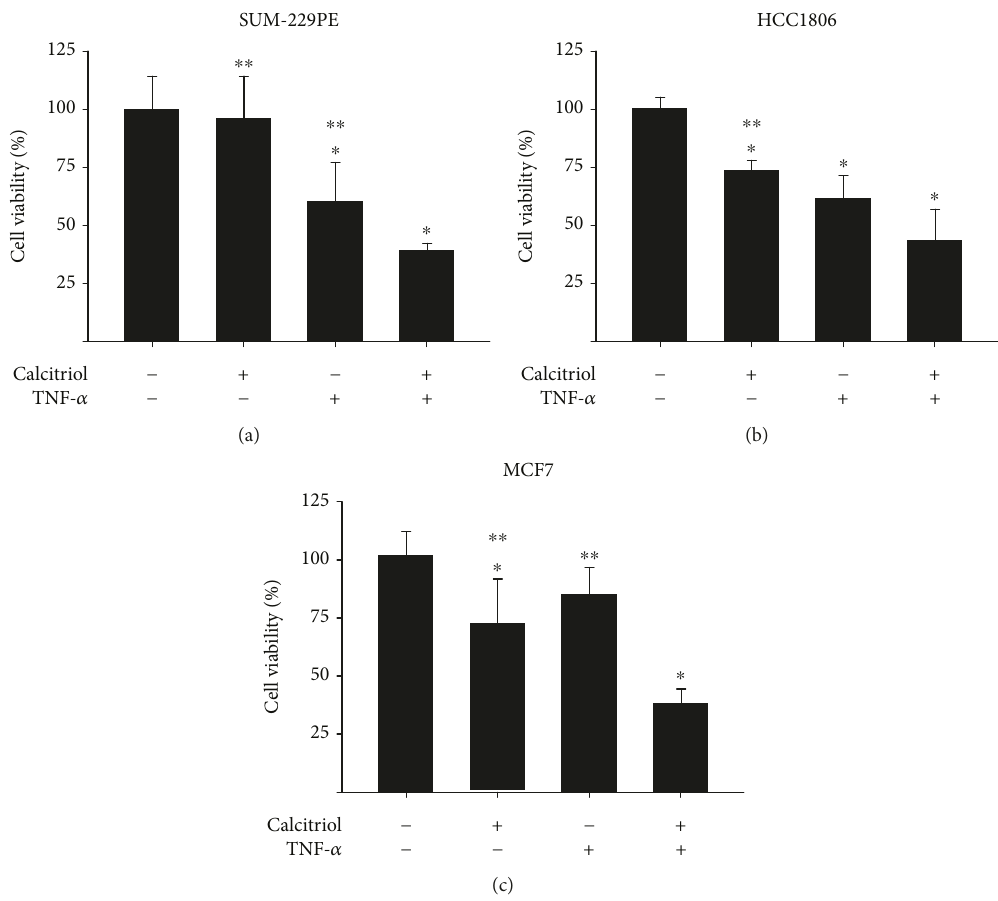
Figure 6: The combination of calcitriol and TNF- α inhibited cell proliferation in a greater extent than each compound alone. SUM-229PE (a), HCC1806 (b), and MCF7 (c) cells were incubated with calcitriol, TNF- α , or their combination during 6 days, and cell proliferation was evaluated. Calcitriol was used at the concentrations of 0.1, 100, and 10nM in SUM-229PE, HCC1806, and MCF7 cells, respectively, and TNF- α at a concentration of 5ng/ml in all cases. Data from vehicle-treated cells (-) were normalized to 100%. The results represent the average of 3 experiments, each in triplicate ± SD . ∗ P < 0 05 vs. vehicle and ∗∗ P < 0 05 vs. combined